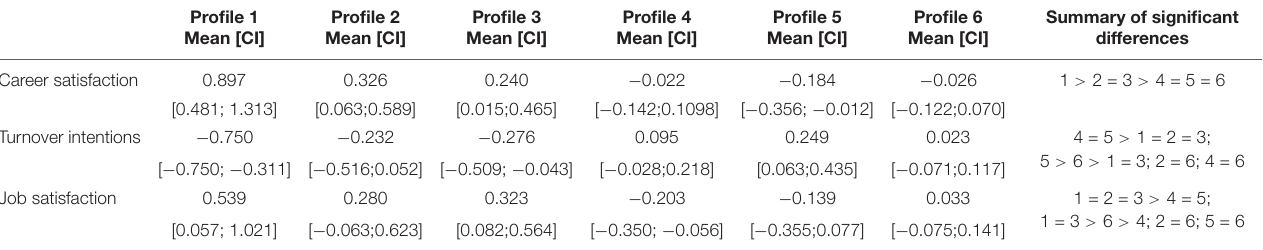
TABLE 3 | Associations between profile membership and the